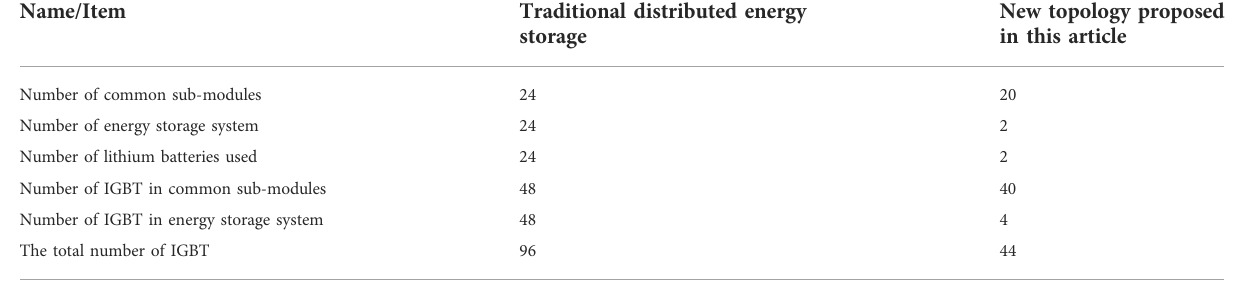
TABLE 3 Comparison of two system topologies.